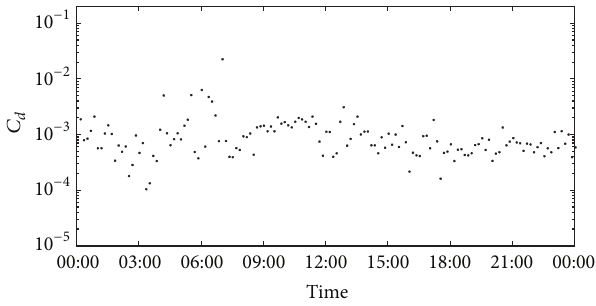
Figure 5: Drag coefficients during typhoon Hagupit from 0:00am to 23:59 pm on September 24, 2008, at 60 m